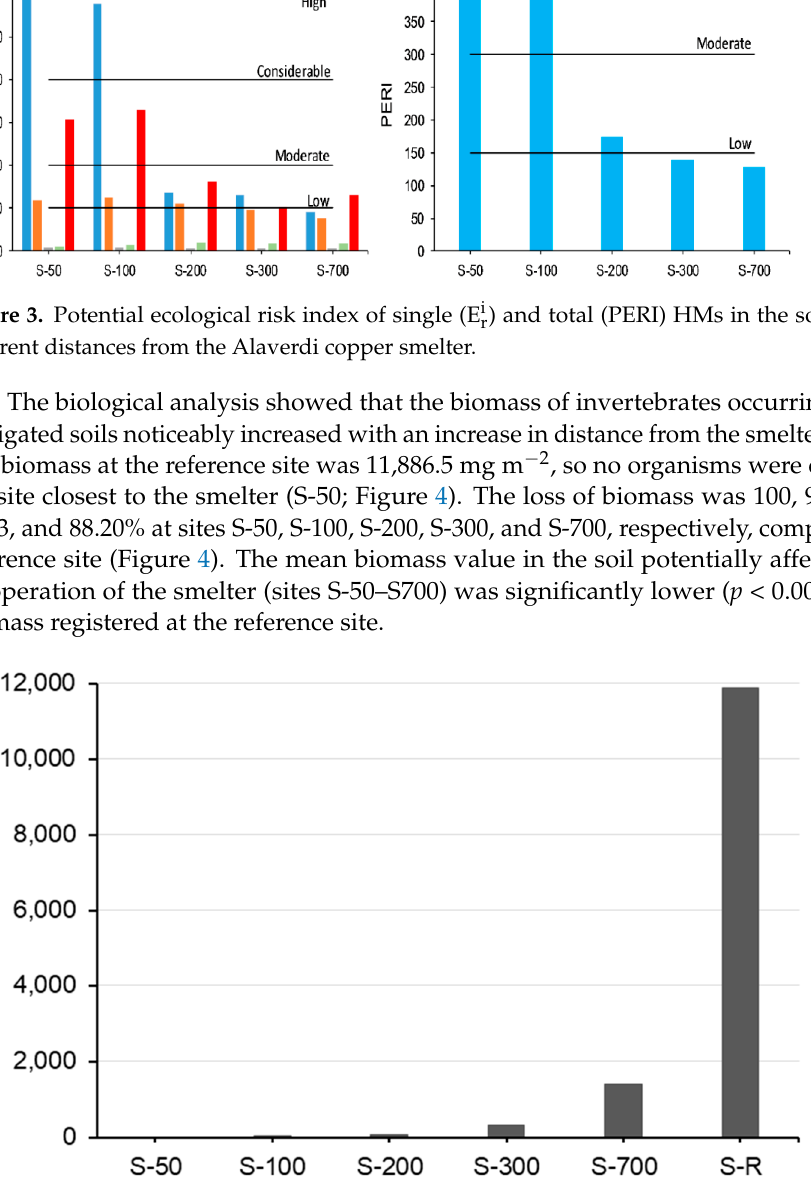
Figure 4. Biomass of invertebrates occurring in the soil located at different distances from the Alaverdi copper smelter.